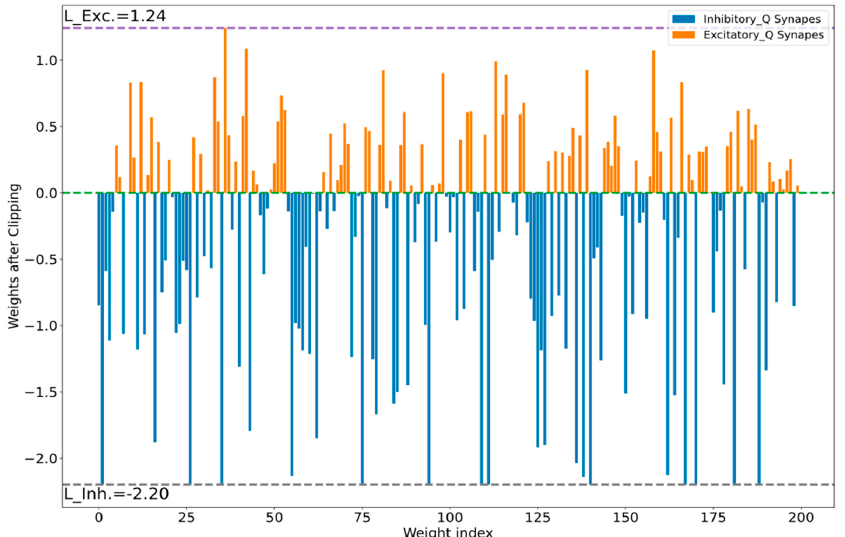
Figure 8. SNN output layer 32-bit floating-point weights after clipping the outlier excitatory and inhibitory weights to increase integer weight resolution.